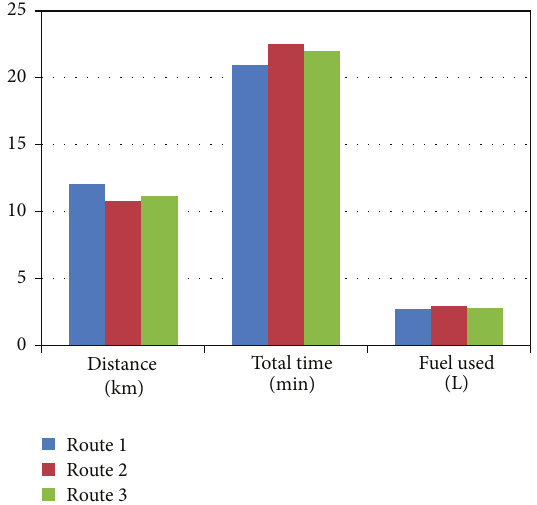
Figure 9: Bar graph for the distance, total travel times, and fuel used in moderate congestion.